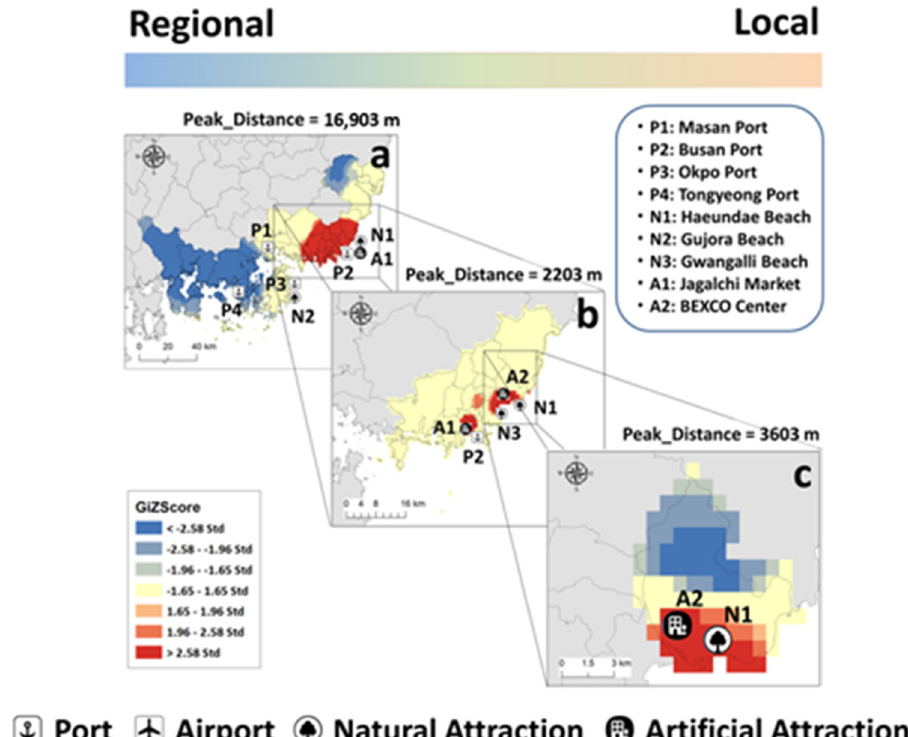
Figure 7. Spatial pattern changes in hotspots by spatial administrative unit: ( a ) Gyeongsangnam-do; ( b ) Busan city; ( c ) Haeundae